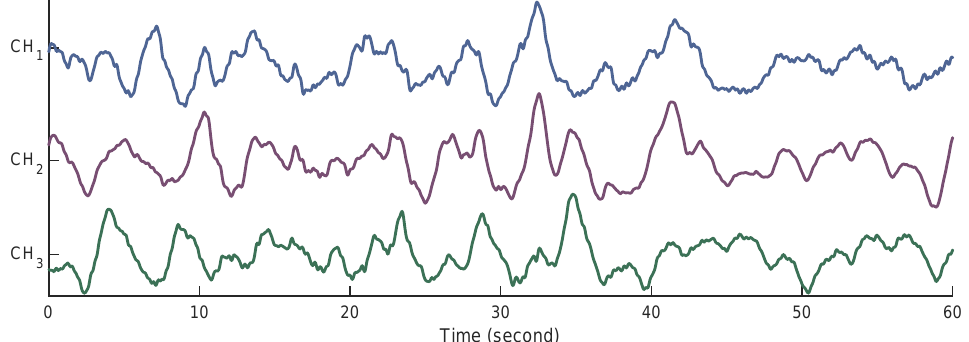
Figure 3. Examples of the EHG signals from all three